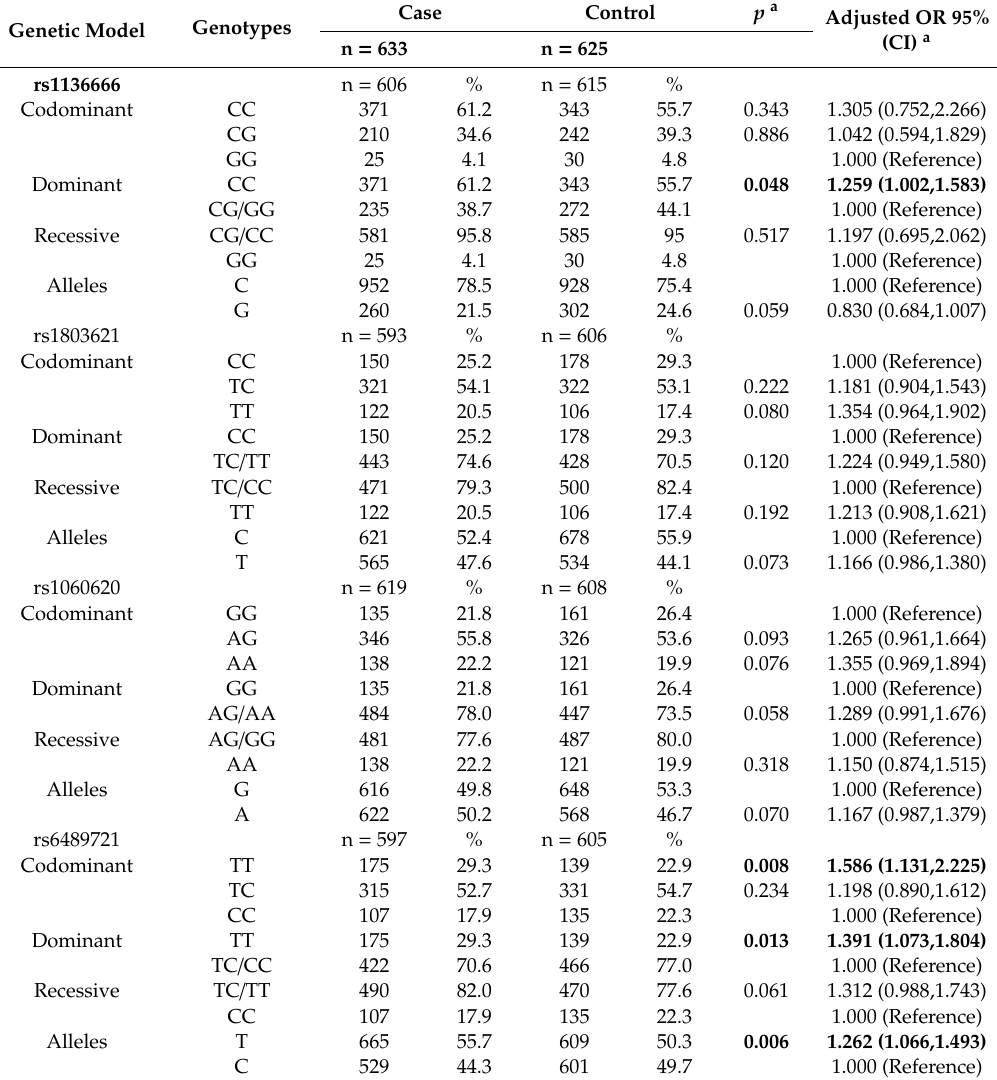
Table 4. Distribution of four SNPs and associations with